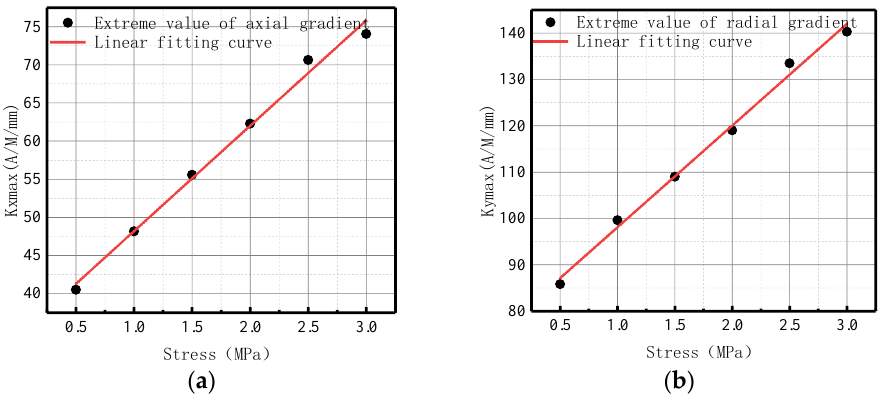
Figure 15. Kmax variations at weld crack with internal pressures. ( a ) Axial component of Kmax ; ( b ) radial component of Kmax .